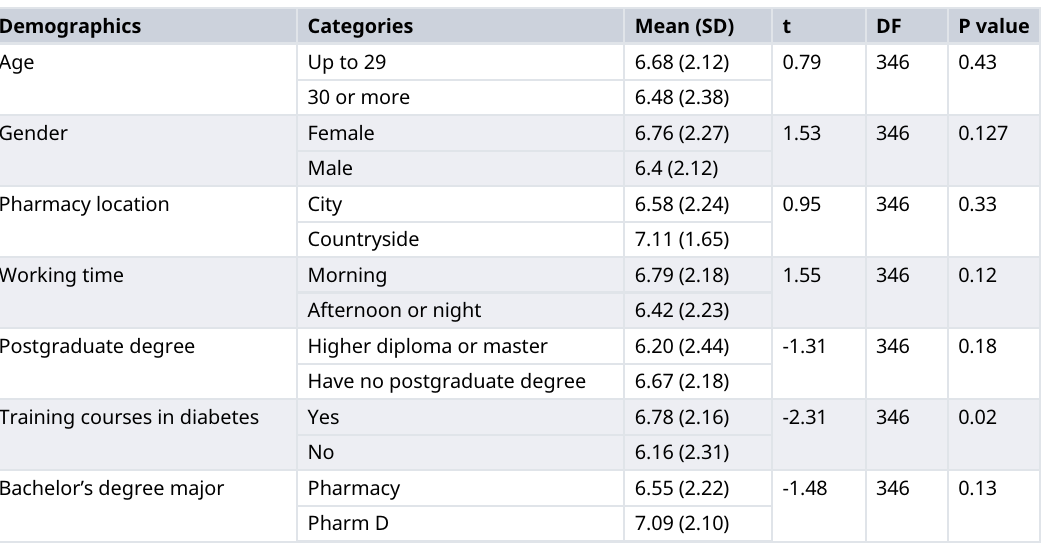
Table 3. Differences in knowledge based on demographics with two categories (independent